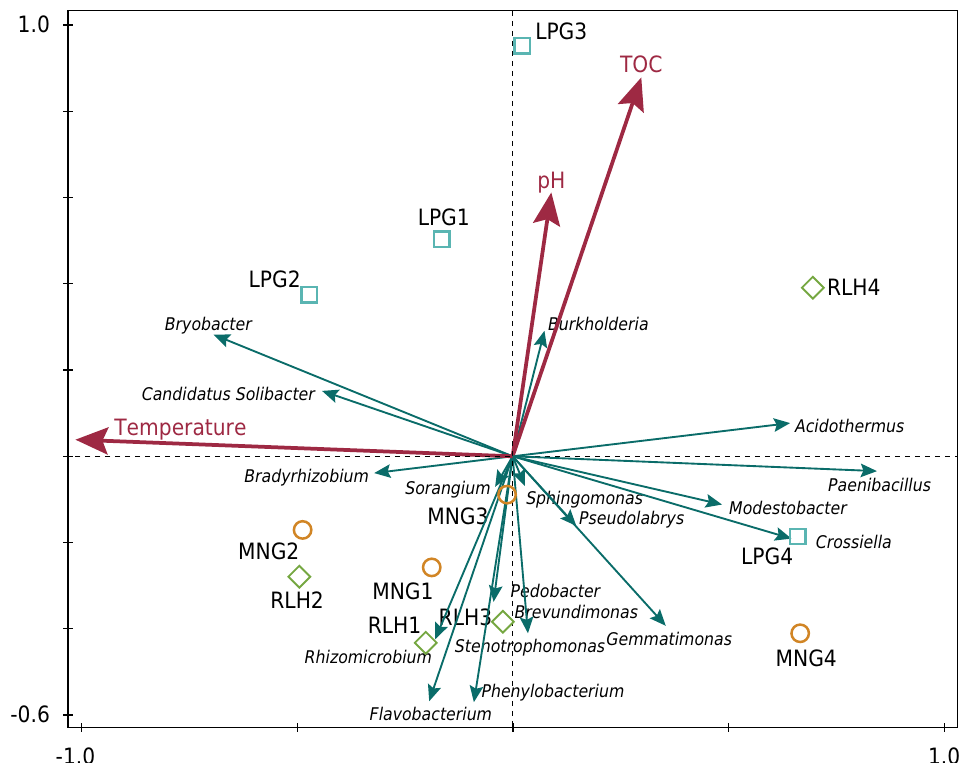
-1.0 Figure 8. Redundancy analysis (RDA) of the relationship between the soil physicochemical properties and the relative abundance of each bacterial genus of the twelve soil samples (p<0.05). Different symbols in the graph represent soil samples from different treatments: Circle: MNG; Square: LPG; and Diamond: RLH. Arrows indicate the direction and magnitude of each variable. Note: RLH: raising laying hens under forest; LPG: cultivating Lolium perenne grass under forest; MNG: maintenance of native grass under forest. The number after the treatment symbol means: 1 = spring; 2 = summer; 3 = autumn; 4 = winter. Bottle green lines represent bacterial genus; red lines represent environmental